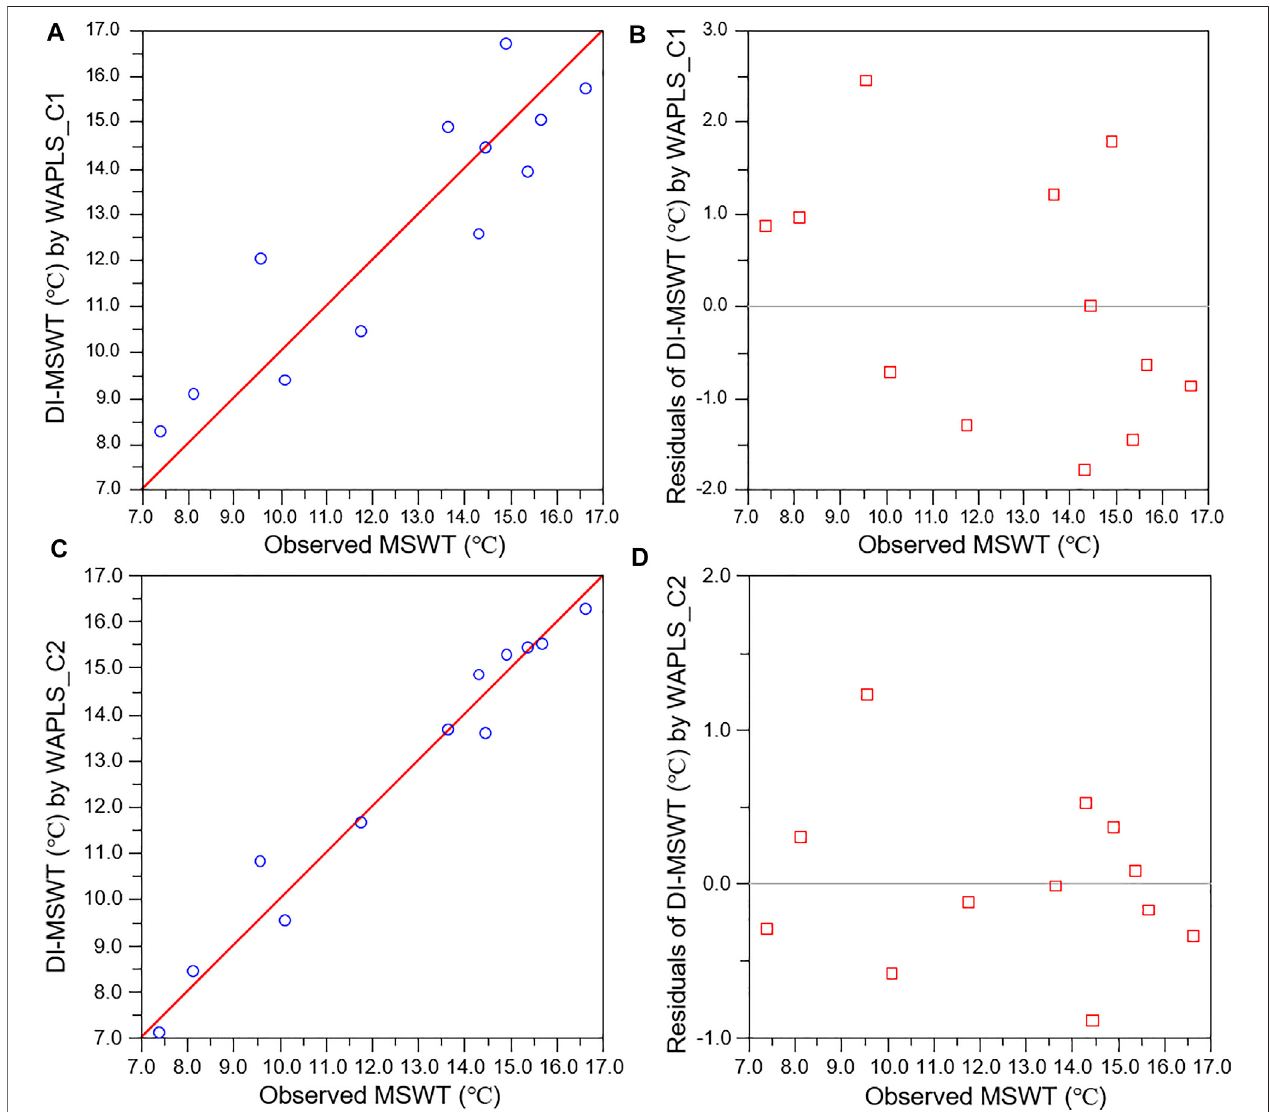
FIGURE 4 | Performance of the diatom-inferred mean surface water temperature (DI-MSWT) transfer function for Yunlong Lake, constructed by WAPLS (Components 1, 2) method. (A) Regression analysis results of the DI-MSWT using Component 1 and the measured dataset. (B) Residuals of the DI-MSWT using Component 1. (C) Regression analysis results of the DI-MSWT based on Component 2 and the measured dataset. (D) Residuals of the DI-MSWT using Component 2.